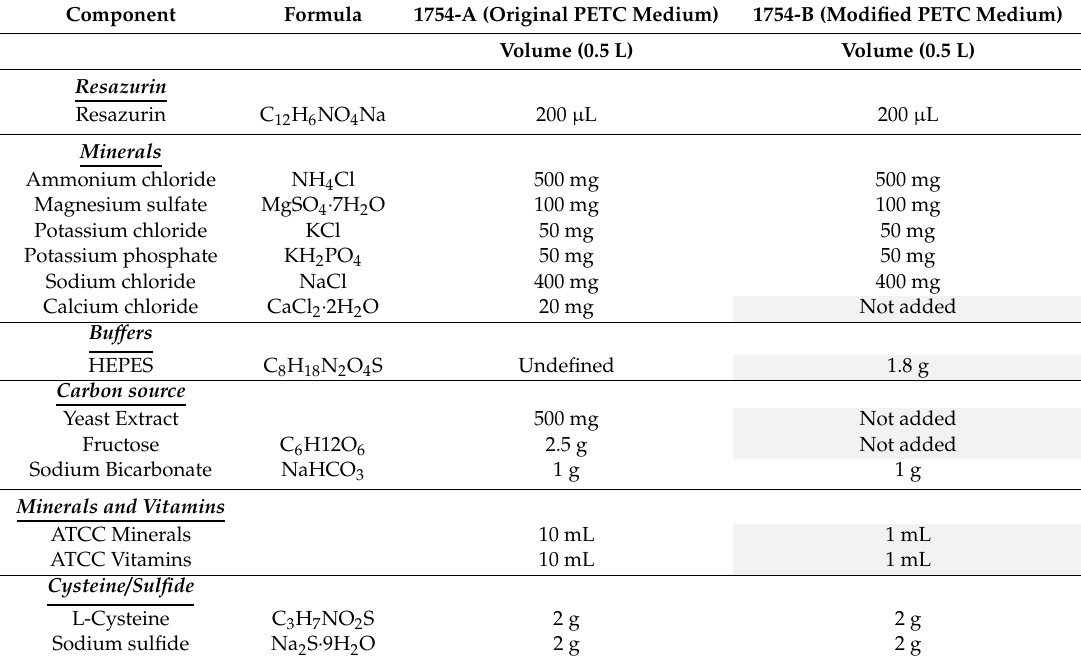
Table 1. Composition of the optimized 1754-B medium used in this study. The original PETC medium (1754-A) was used with some modifications as shown below